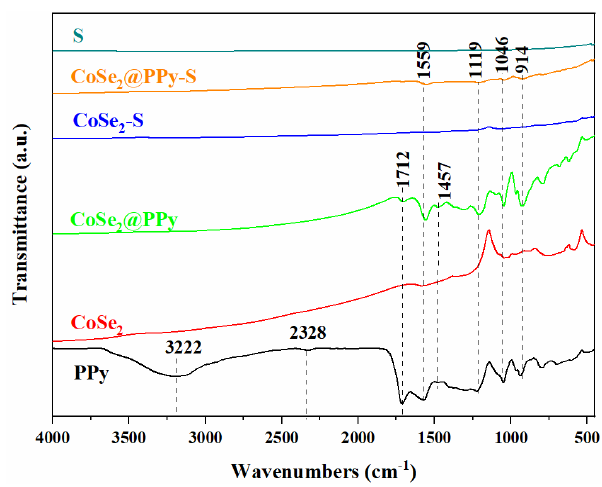
Figure 3. FTIR spectra of PPy, CoSe 2 , CoSe 2 @PPy, S, CoSe 2 @PPy-S, and CoSe 2 -S composites.